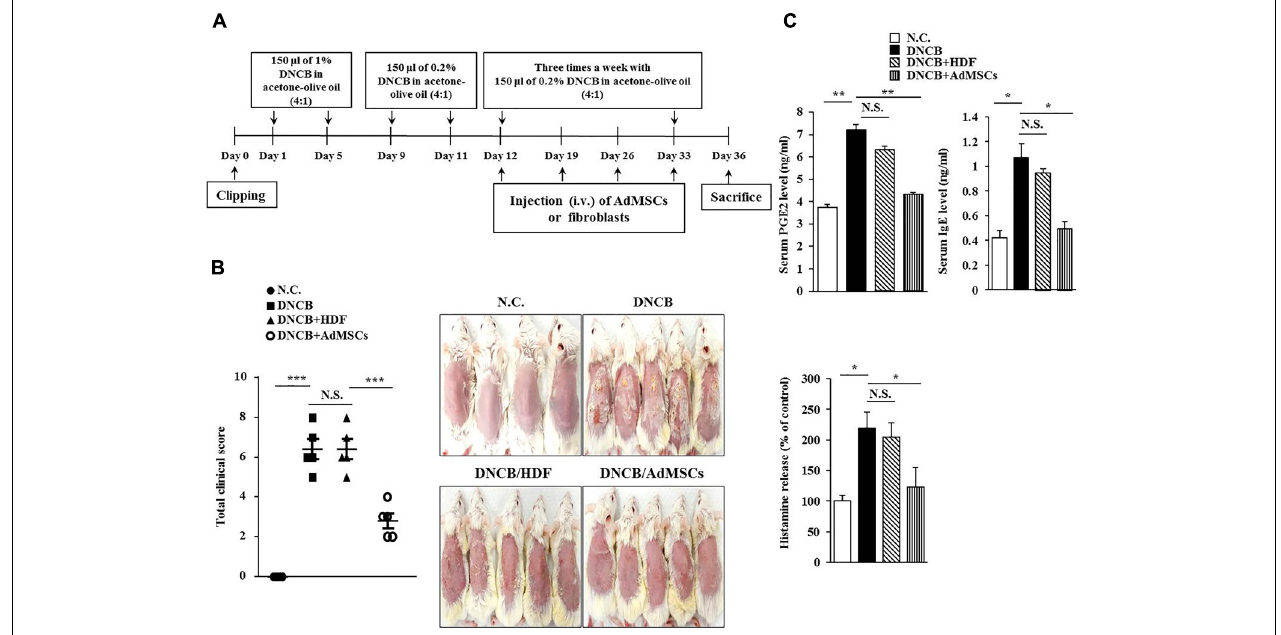
FIGURE 1 | Human adipose tissue-derived mesenchymal stem cells (AdMSCs) attenuate the clinical symptoms associated with atopic dermatitis (AD). (A) 2, 4-dinitro chlorobenzene (DNCB) was employed to induce AD in BALB/c mice. Human dermal fibroblasts (HDFs) or AdMSCs were intravenously injected once a week. (B) At the indicated day (day 36) after the induction of AD, clinical scores of BALB/c mice of each experimental group were determined. ∗∗∗ p < 0.0005. N.C., negative control; N.S., not significant. (C) Sera of BALB/c mice of each experimental group were employed for the determination of prostaglandin E2 (PGE2) level, IgE level, and the amount of histamine released. ∗ p < 0.05; ∗∗ p < 0.005.